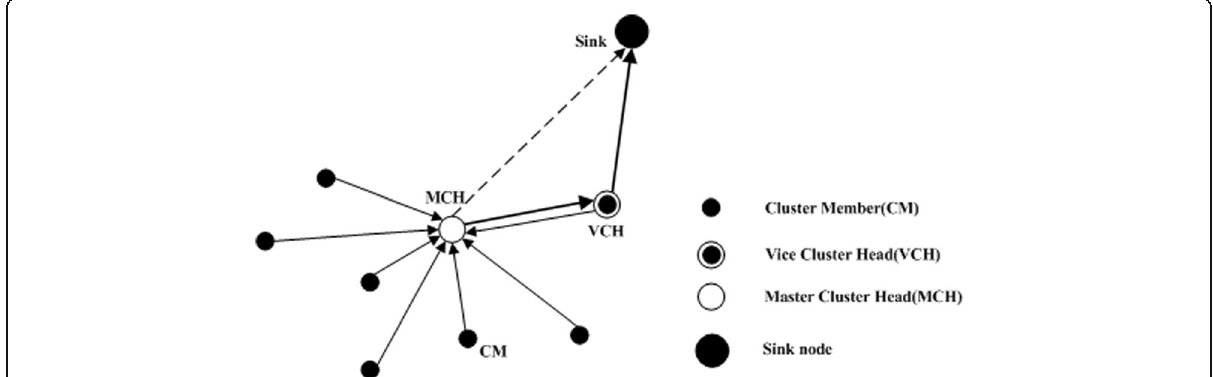
Fig. 2 ADCAPTEEN network model. The ADCAPTEEN network model consists of CM, MCH, VCH, and sink node in four parts. In each cluster, a MCH and a VCH are selected. The CM is responsible for collecting and transmitting data to the MCH. The MCH collects and merges the data, sends the converged data to the VCH of the cluster, and the VCH forwards the data to the sink node at a far